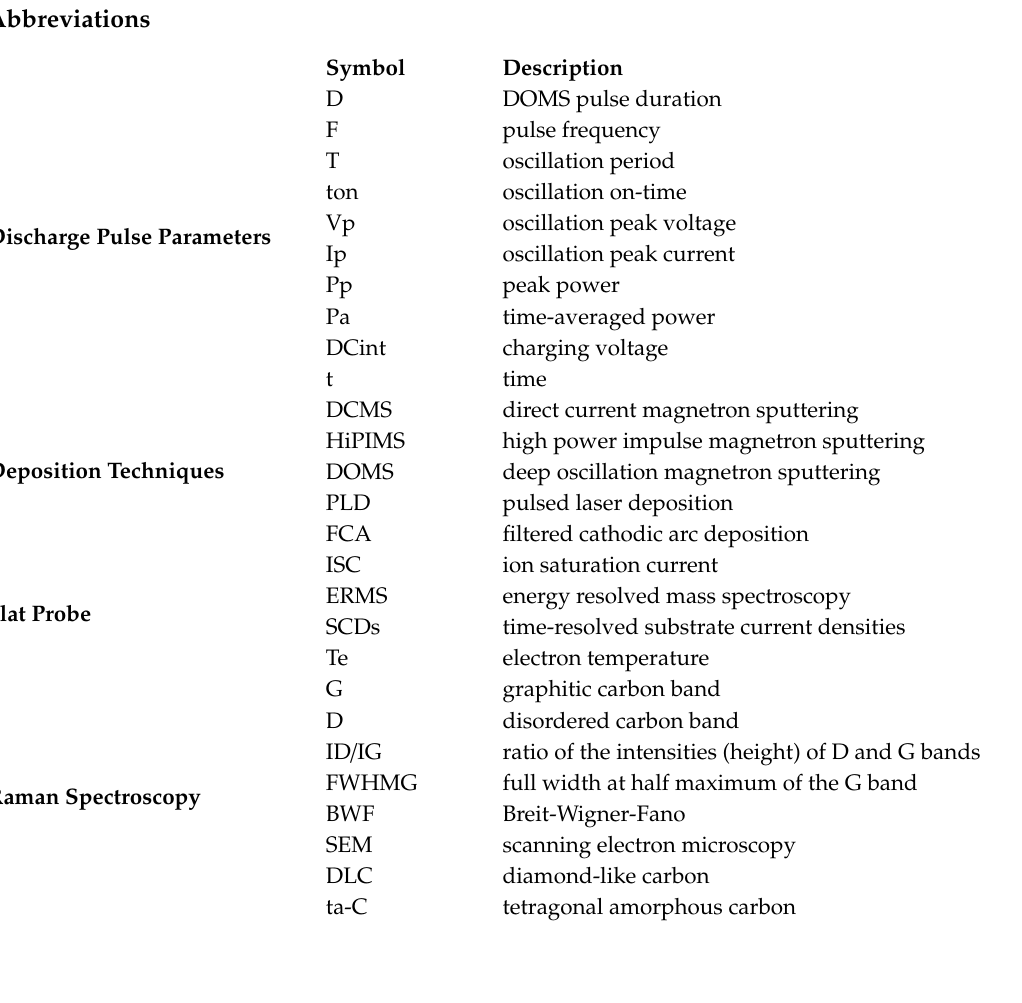
Figure S1: SEM micrographs ( a – p ) of DLC